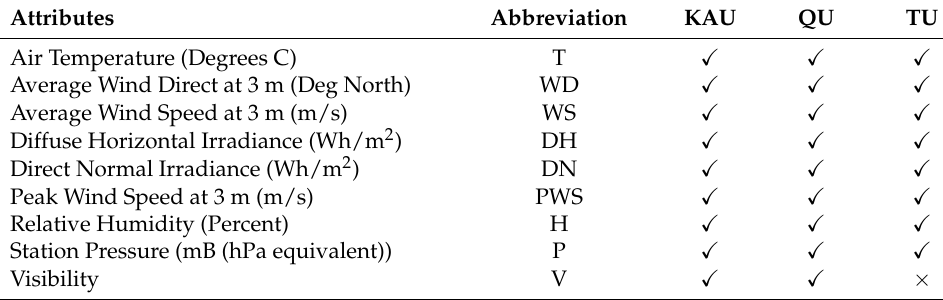
Table 1. Solar attributes used in the current experiment. Attributes